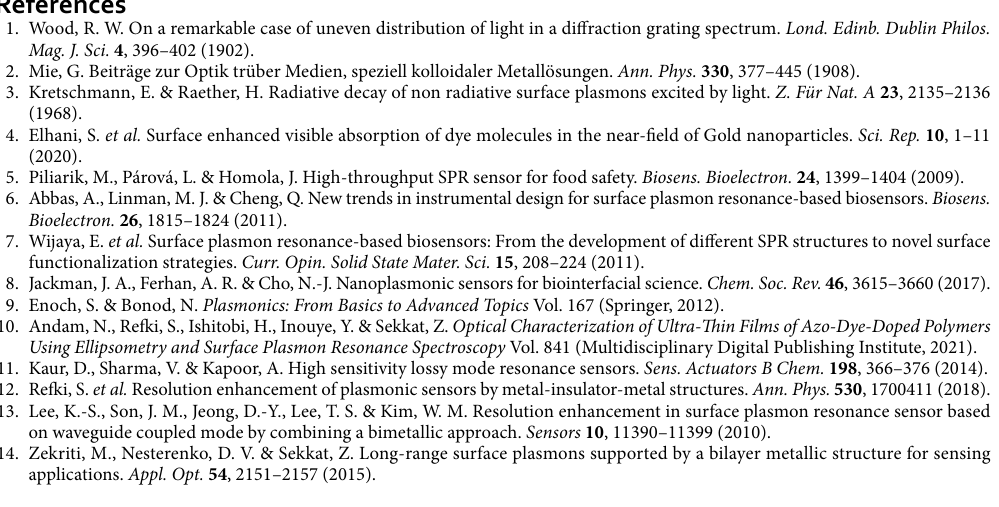
for the same (cid:31) n , which is a property of the SL, not the sensor, we observe larger reflectivity changes ( (cid:31) R in Fig. 5c) and mode shifts ( �θ in Fig. 6) for CSPR versus MIM sensors. It can be seen from both Figs. 5c and 6,